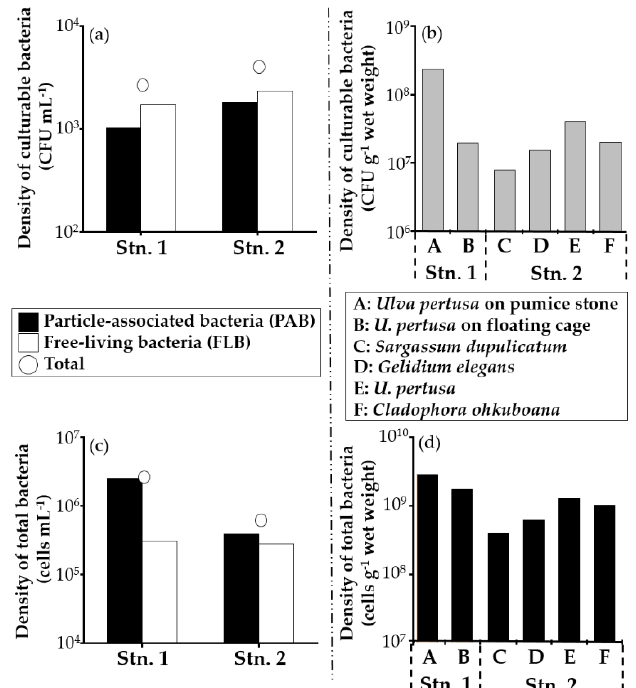
Figure 3. The densities of culturable bacteria ( a ): seawater, ( b ): macroalgal biofilms and total bacteria directly counted with DAPI staining ( c ): seawater, ( d ): macroalgal biofilms and at Stns. 1 and 2. Total ( ○ ) shown on ( a ) and ( c ) are expressed as the sum of particle-associated bacteria (PAB) and free-living bacteria (FLB). A to F are macroalgal samples used to enumerate the densities.